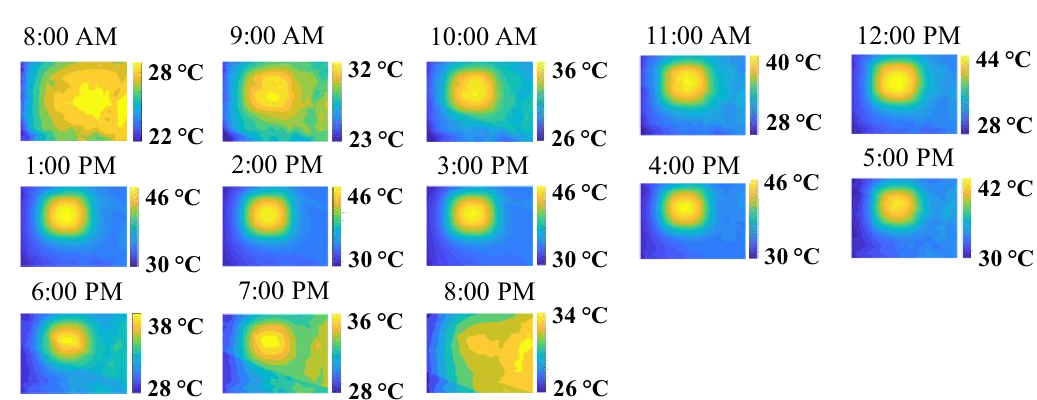
Figure 12. Highlighted simulation results of the slab experiment.